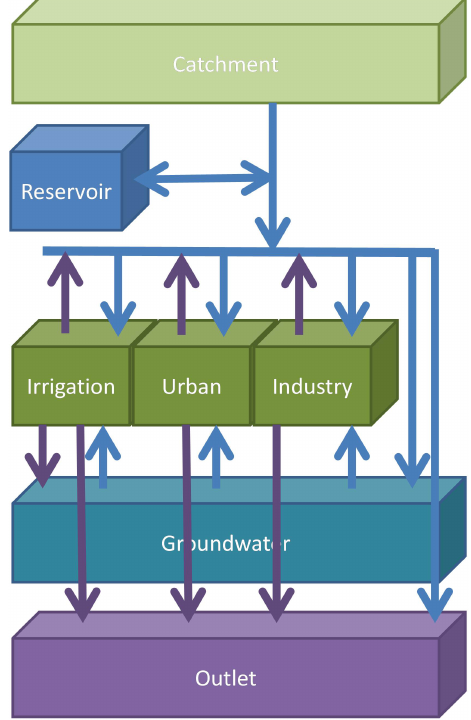
Fig. 2. Conceptual framework of the MENA Water Outlook Frame- work